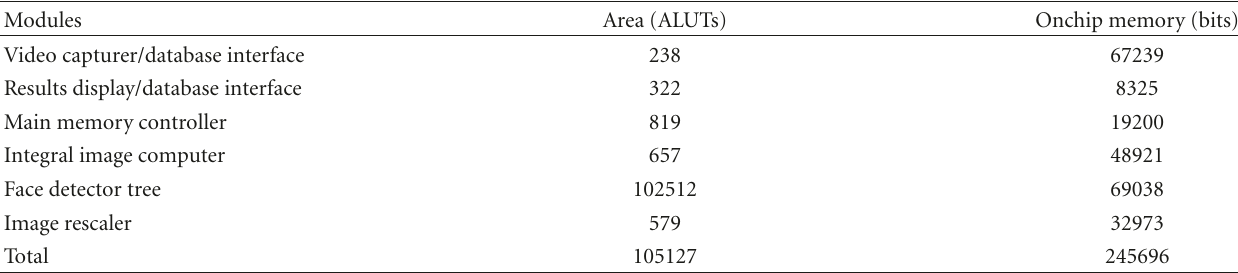
Table 4: Resource utilization for di ff erent parts of the system.